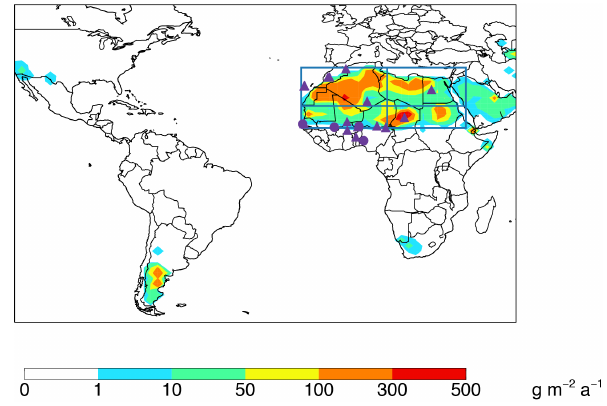
Figure 2. GEOS-Chem emissions of dust during January–April 2014 over 120 ◦ W–60 ◦ E and 60 ◦ S–60 ◦ N. Blue lines show the lim- its of the four selected regions for the dust sensitivity runs (see text). The purple dots and triangles are the AERONET sites used in the text. The purple dots are the AERONET sites used in Fig. 3.